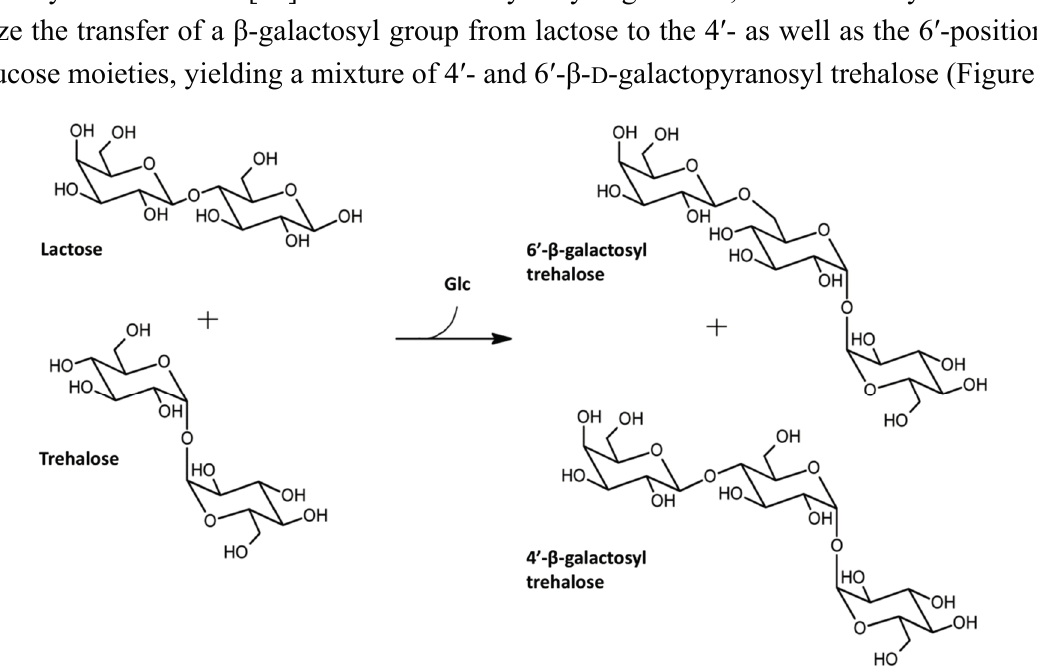
Figure 4. Pathway for synthesis of trehalose trisaccharide analogues via E.